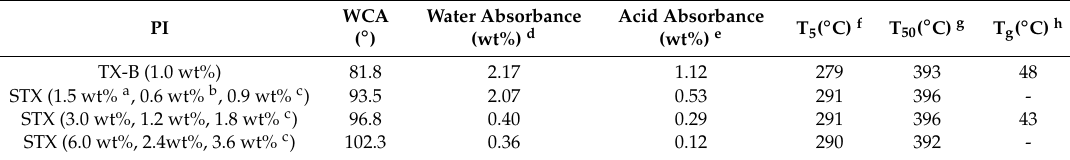
Table 1. The physical data of the cured PUA films initiated by TX-B and STX. PI